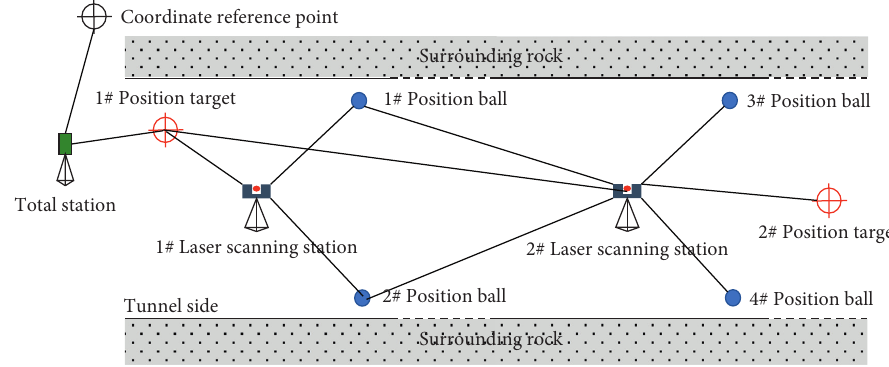
Figure 5: Schematic diagram of the 3D scanner scanning